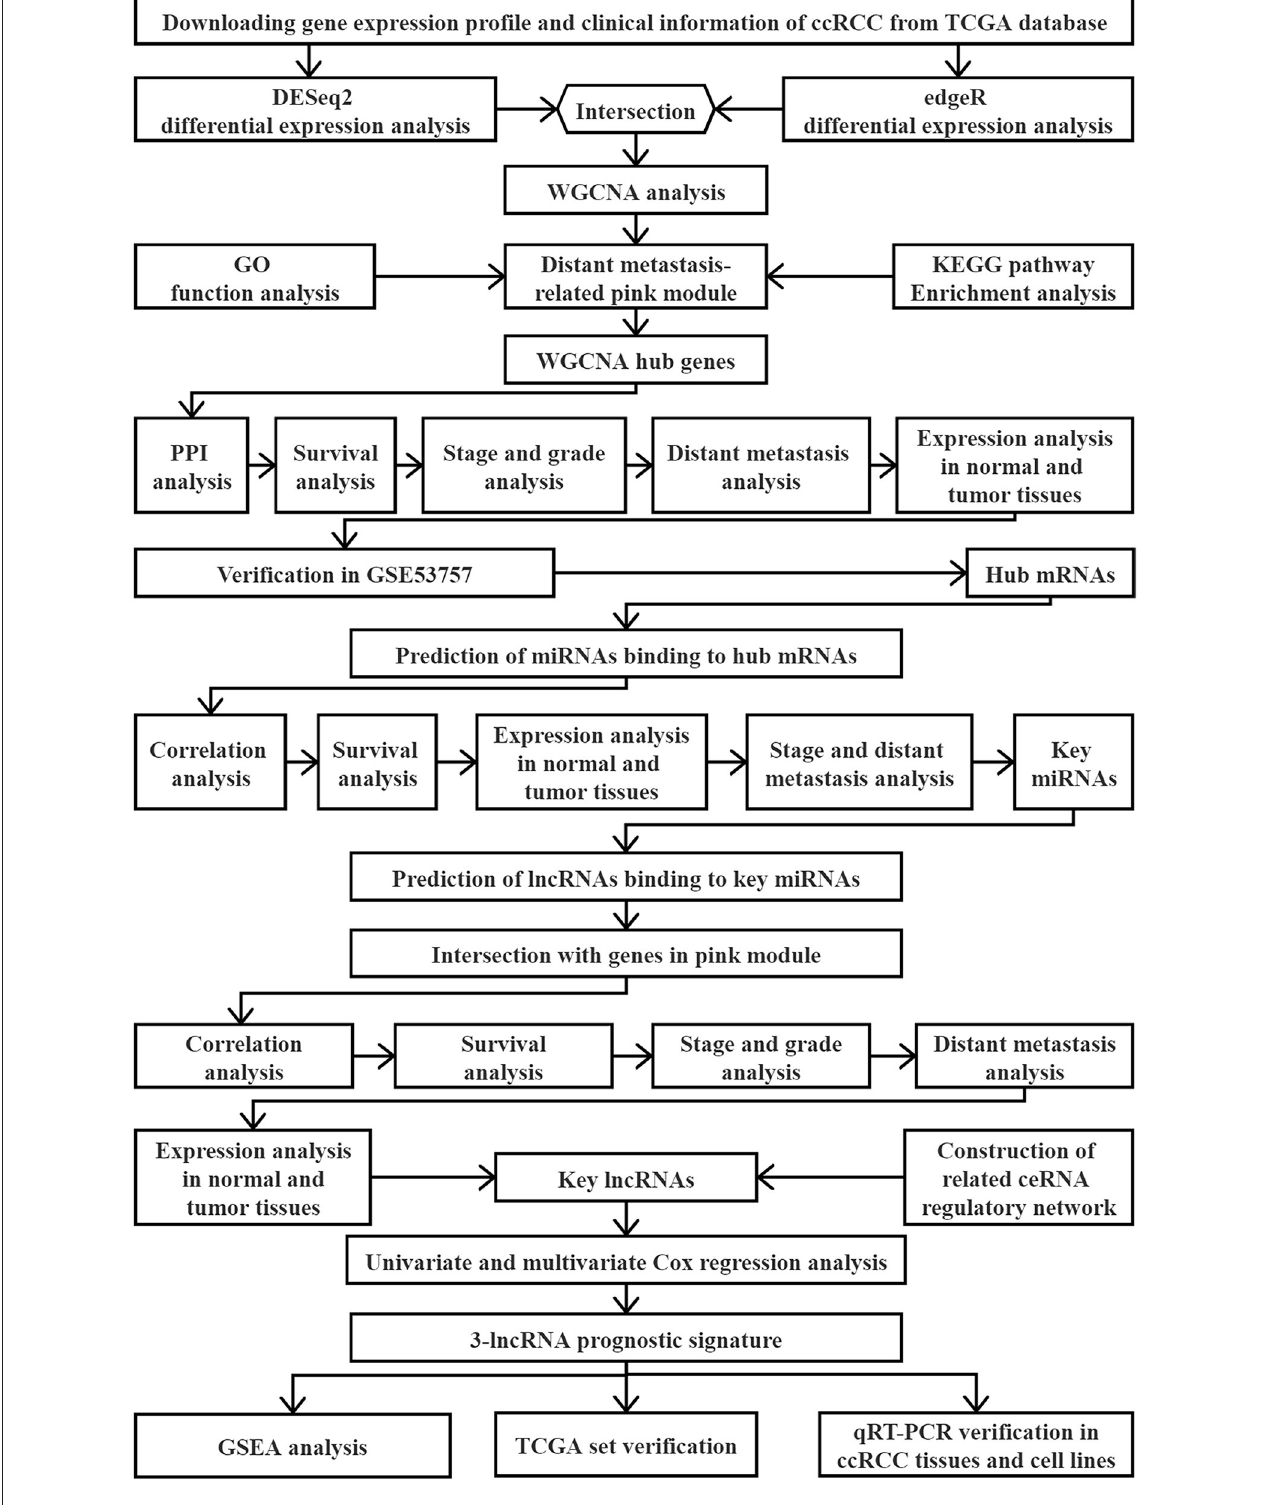
FIGURE 1 | Flow chart of the study.